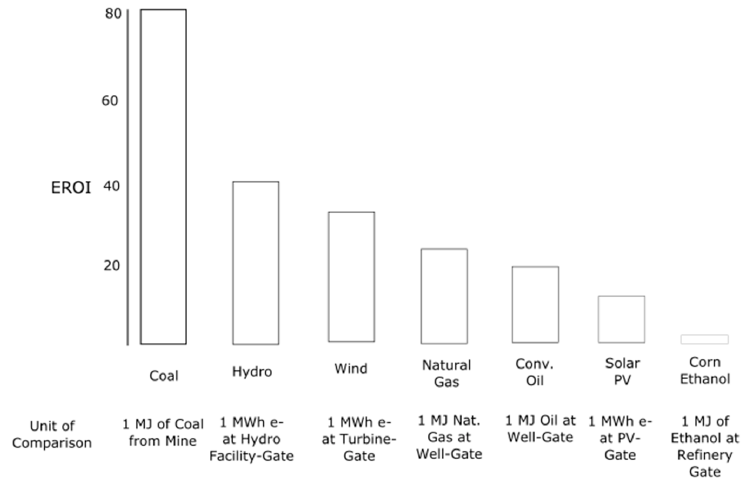
Figure 1. Comparison of the EROI for various energy resources and listing an assumed common unit of comparison (data adapted from figure in [1]).